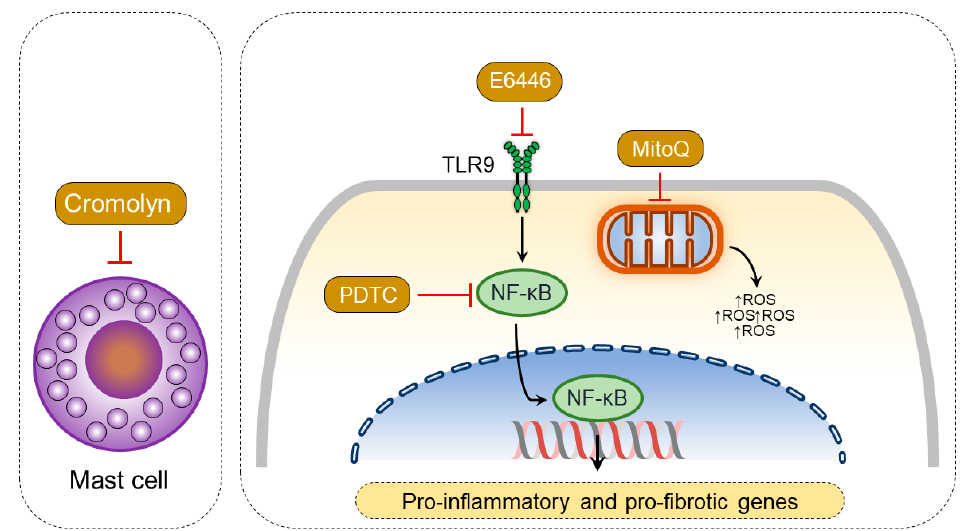
Figure 5. Mechanisms of agents attenuating myocardial inflammation and oxidative stress in pulmonary artery banding (PAB)-induced right ventricular (RV) remodeling. E6446, an inhibitor of TLR9, and pyrrolidine dithiocarbamate (PDTC), an inhibitor of NF- κ B, attenuate inflammatory cell activation and expression of proinflammatory genes. Cromolyn, a mast cell stabilizer, inhibits mast cell degranulation and prevents the release of proinflammatory mediators. MitoQ inhibits mitochondria-derived ROS production and oxidative stress. In summary, these agents inhibit myocardial inflammation and oxidative stress and thereby improve RV function and adaptation to pressure overload.